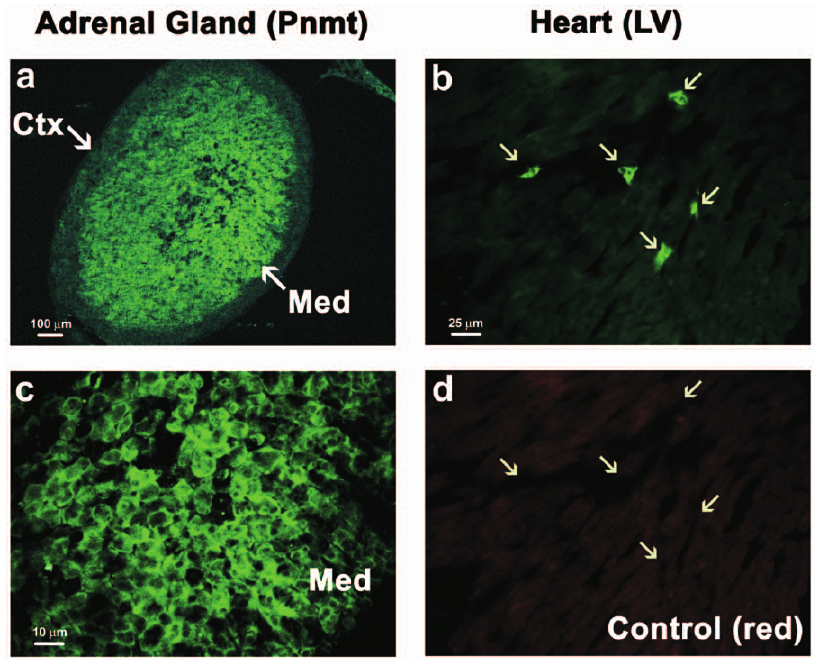
Figure 7. Active Pnmt expression in the adult mouse adrenal glands and heart. The adrenal gland and heart of adult Pnmt + /Cre , ROSA26 + / b gal mice were extracted to evaluate the distribution of active Pnmt expression. Cryosections of the mouse adrenal gland were immunofluorescently stained to identify Pnmt expression (green). The adrenal medulla (Med) showed bright positive staining as expected, while the cortex (Ctx) of the adrenal gland showed only background fluorescence (a). High magnification images of Pnmt immunofluorescent staining in the LV reveals small cells positive for cytoplasmic Pnmt expression in the heart (b, arrows) and adrenal medulla (c). Negative control for the LV image shown in panel b illustrates the absence of fluorescent signal in the red spectrum